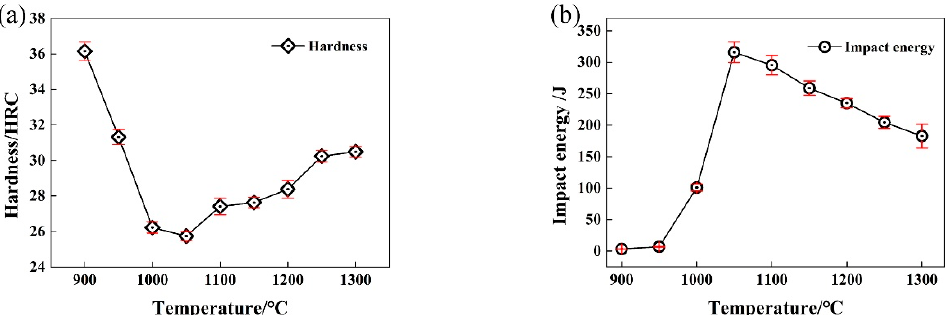
Figure 11. Mechanical properties of the UNS S32750 steel vary with solution treatment temperature. ( a ) Hardness; ( b ) impact energy (error bars represent standard deviation).